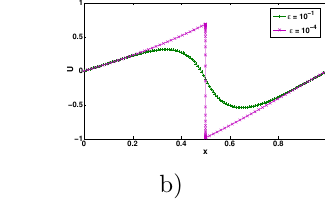
Figure 3. Numerical solutions for: a) Example 2 on the mesh Ω N for N = 128, b) Example 3 on the mesh Ω N for N = 128.